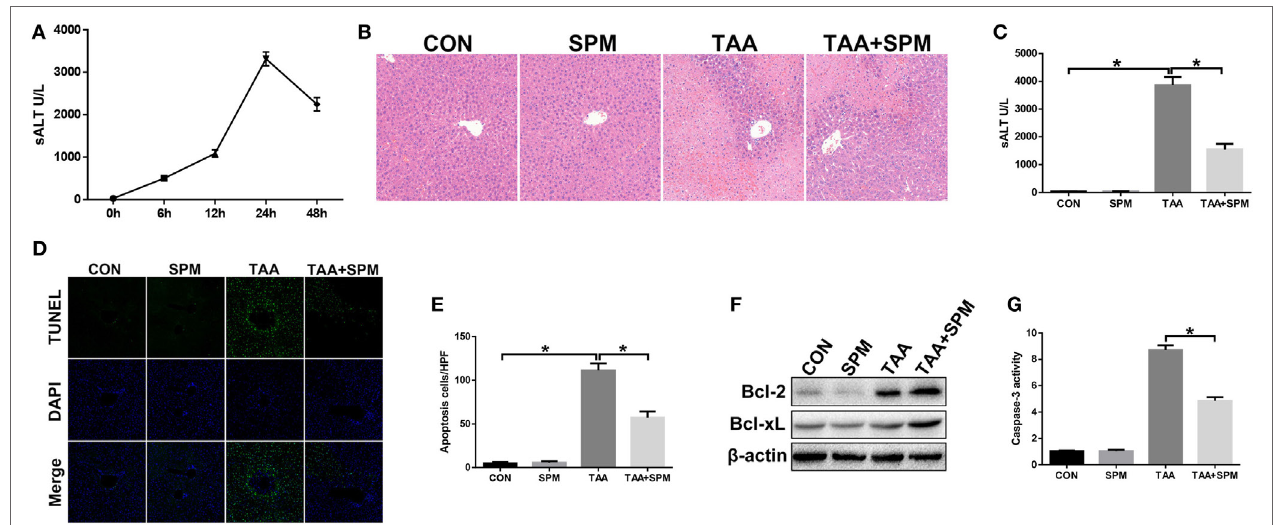
FigUre 1 | Spermine (SPM) pretreatment attenuates thioacetamide (TAA)-induced acute liver injury. Mice were subjected to SPM pretreatment and TAA administration as described in Section “Materials and Methods.” TAA-induced acute liver injury was evaluated by serum alanine aminotransferase (ALT) levels at different time points [ (a) , n = 6/group]. Liver injury was evaluated in terms of liver histopathology [ (B) , representative of six mice/group] and serum ALT [ (c) , n = 6/ group]. TUNEL staining of liver sections (original magnification 20 × ). DAPI was used for nuclear staining. Representative of six mice/group (D) . Ratio of TUNEL- positive cells in different experimental groups [ (e) , n = 6/group]. Bcl-2, Bcl-xL, and β -actin protein levels were measured by Western blot. Representative of three experiments (F) . Cellular activity was determined by caspase-3 activity assay. Representative of three experiments (g) (* p <